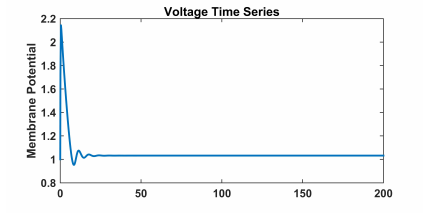
Figure 19. Responses of membrane potential with a constant external current value, I(t) = 4.5 µ A / cm 2 , a = 0.8 , b = 0.7 & c = 3